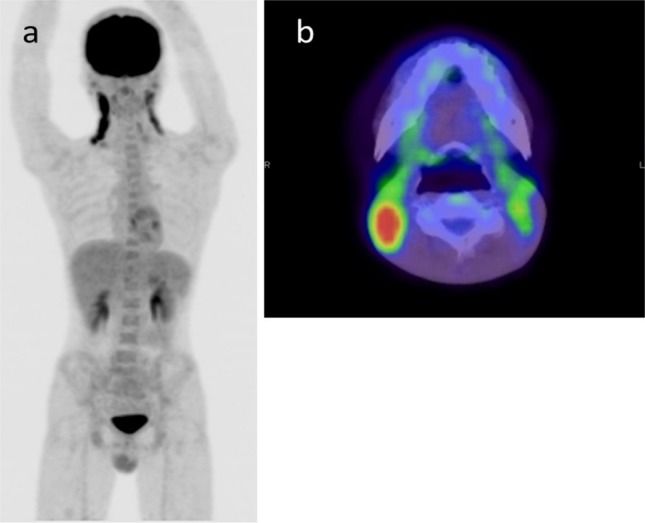
A 21-year-old man with Kikuchi’s disease misdiagnosed as lymphoma;(a) Maximum intensity projection image and (b) fused FDG-PET/CT image of the neck are shown. The patient presented with cervical lymphadenopathy and a fever of 39°C for a month. FDG-PET/CT showed bilateral cervical lymphadenopathy with elevated FDG uptake (SUVmax=8.7). Elevated sIL-2R of 1200 U/ml was also observed. Although the evaluators commented that this case was compatible with lymphoma (degree of suspicion was Grade 3), the final biopsy-proven diagnosis was Kikuchi’s disease